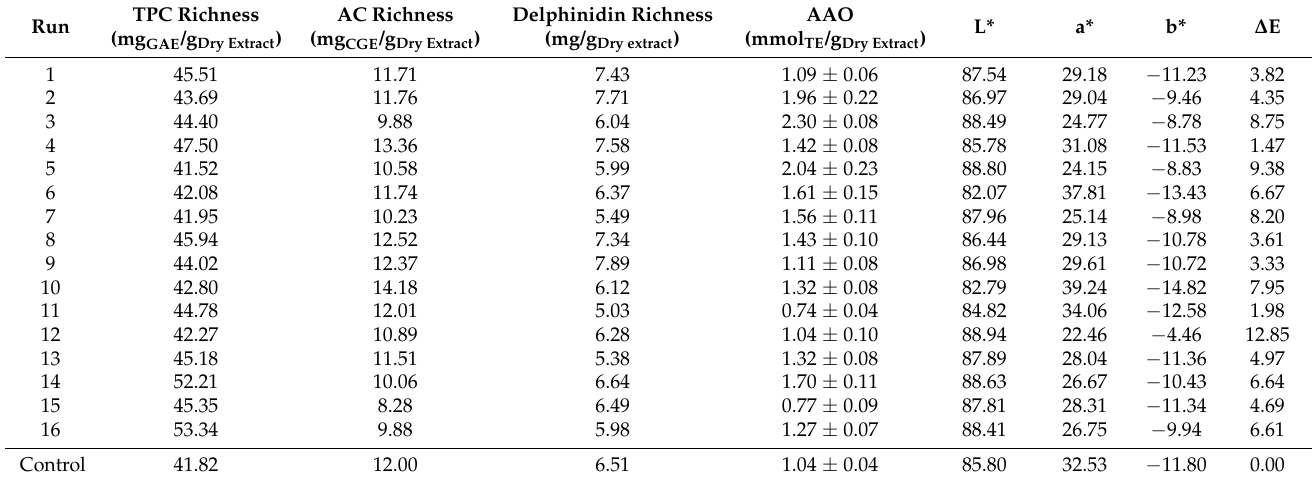
Table 6. Extraction results: richness, antioxidant activity (AAO) and color measurement. TPC Richness AC Richness Run (mg GAE /g DryExtract ) (mg CGE /g DryExtract